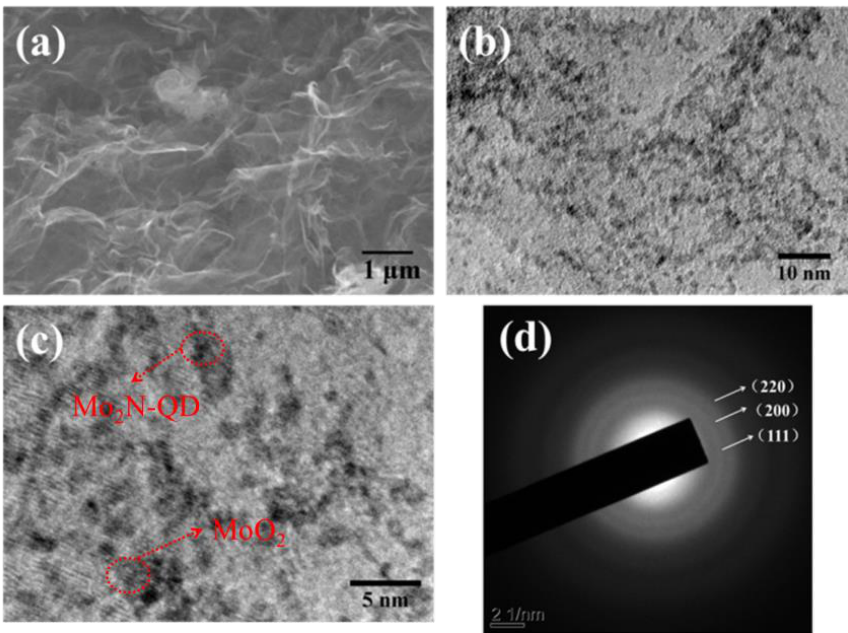
Figure 4. Morphology of MON-QD/NG-600: ( a ) SEM; ( b ) TEM; ( c ) HRTEM; ( d ) SAED. Figure 5a,b are the adsorption and desorption isothermal curves and pore size distri- bution of the three MON-QD/NG samples, respectively. There are obvious hysteresis loops in the three MON-QD/NG composites with a pressure ratio of about 0.8 – 1.0 (Figure